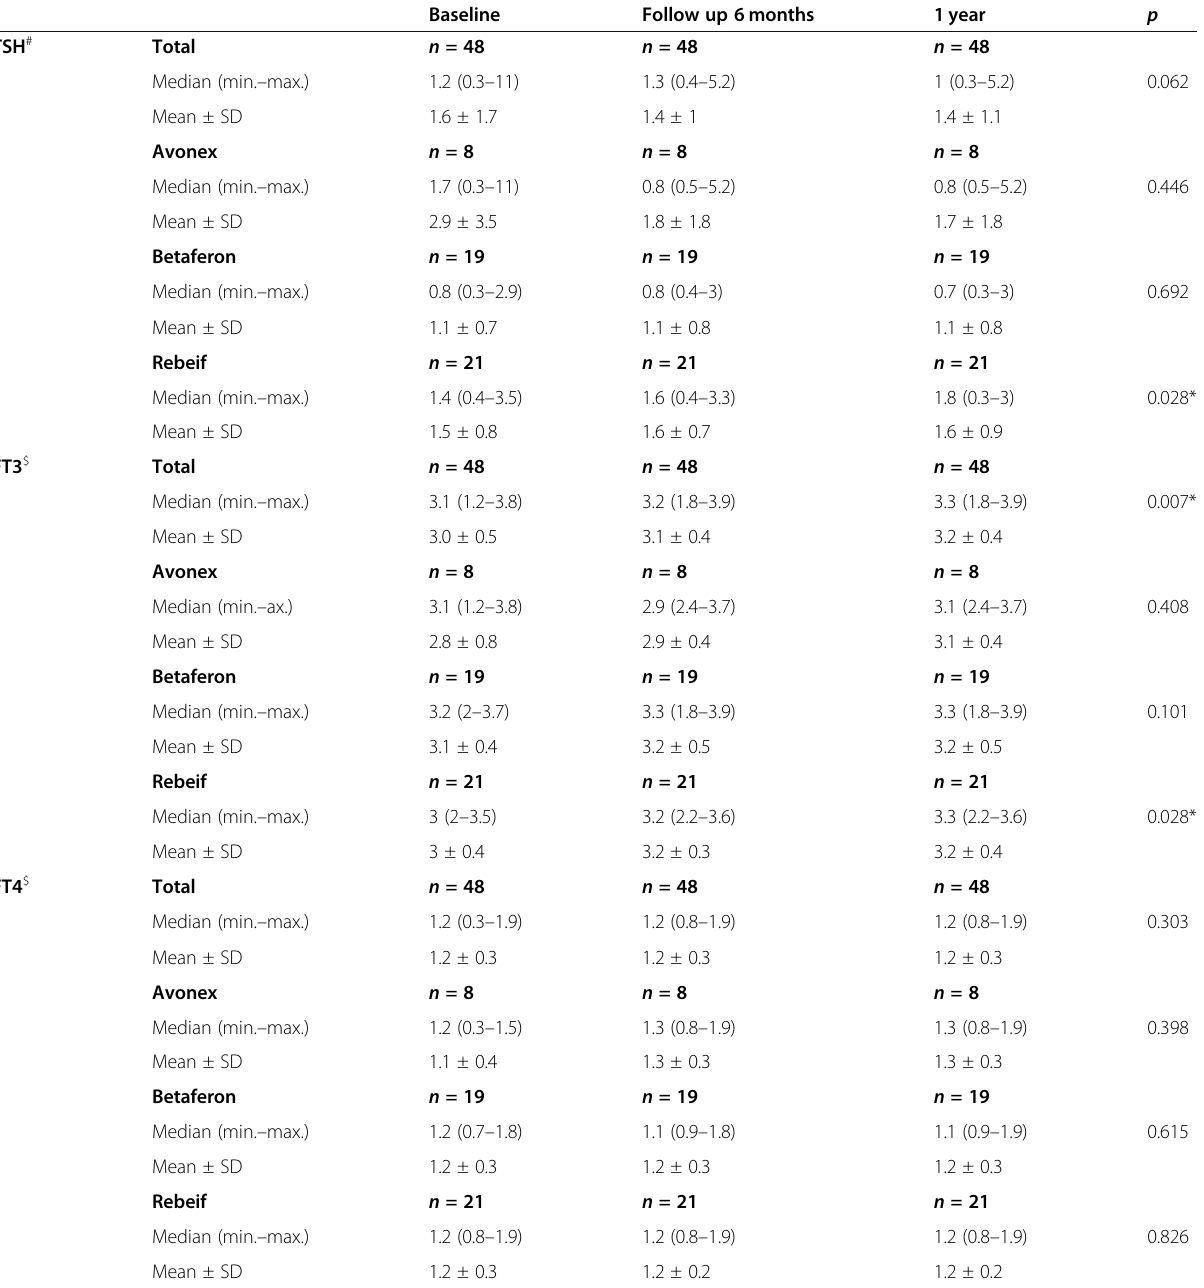
Table 3 Comparison between the different groups at baseline and follow-up periods according to different thyroid profile parameters Baseline Follow up 6 months 1